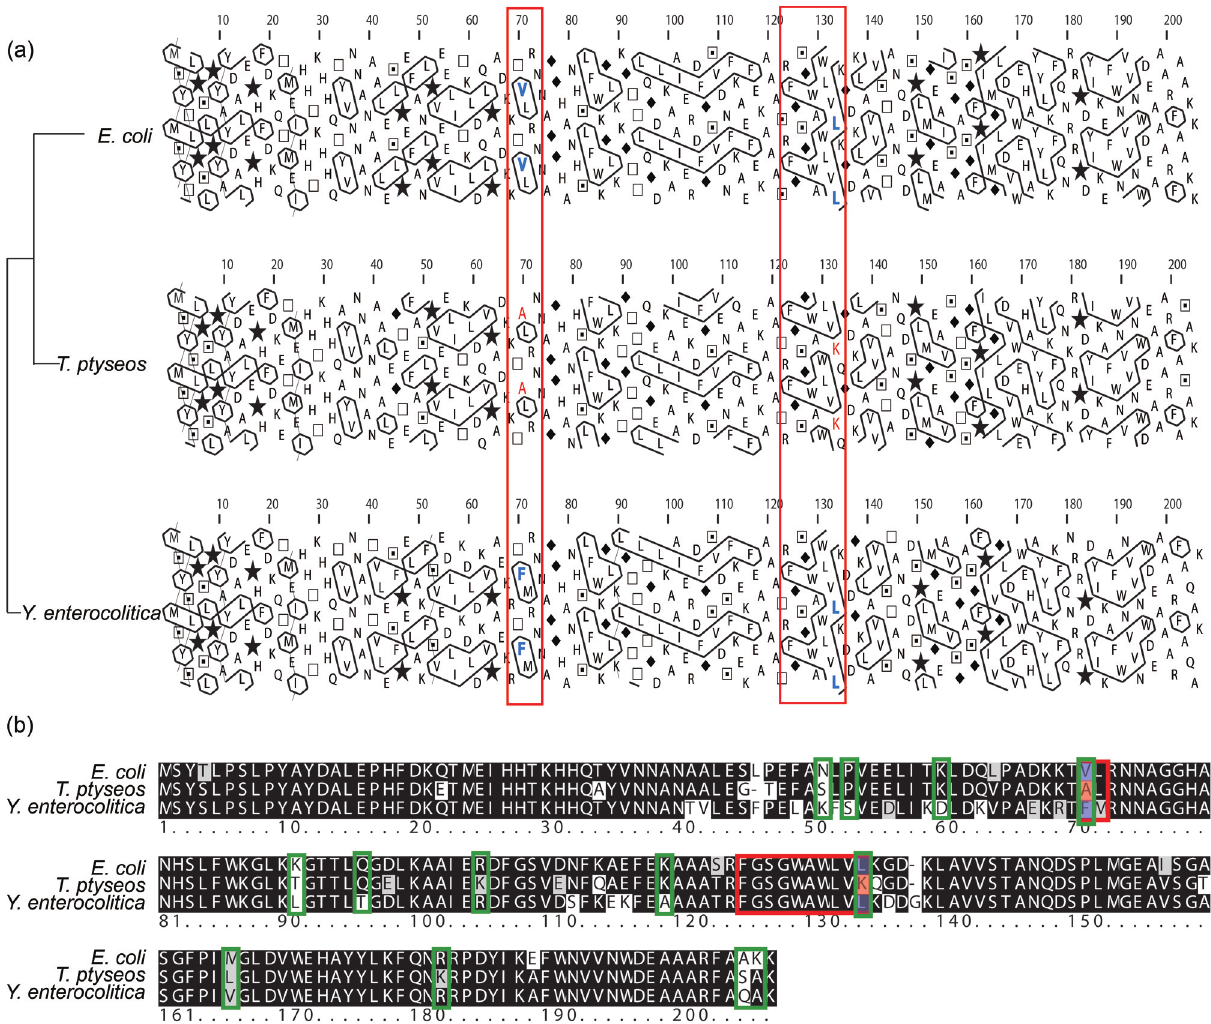
Figure 3 - Comparison of the HCA structure and amino acid sequence of Enterobacteriaceae MnSODs. Note: The similarity in HCA between E. coli and Y. enterocolitica . (A) HCA plot of MnSOD. The vertical red boxes show regions of significant differences based on HCA. Amino acid changes resulting in changes in the HCA plot are in red (hydrophilic) or blue (hydrophobic). The phylogram to the left indicates the likely evolutionary relationship of the taxa in order to compare with changes in hydrophobicity. (B) Amino acid sequence alignment of MnSODs. The black background shows regions where two or more amino acids are totally identical, while the gray background indicates changes resulting in similar amino acids. The positions in red (hydro- philic) or blue (hydrophobic) background show changes in hydrophobicity. The red horizontal boxes enclose regions corresponding to the regions en- closed by the vertical boxes in A. The green boxes enclose the positively selected residues detected by PAML in Table